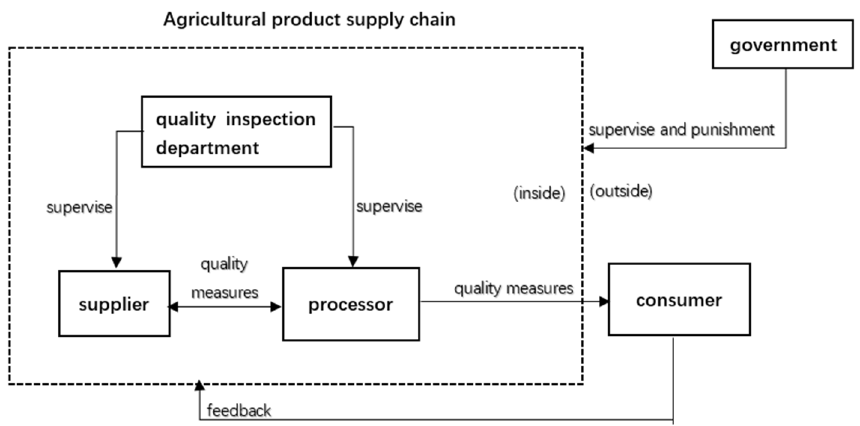
Figure 1. Game relationship among suppliers, processors, and quality inspection departments of agricultural products supply chain. agricultural products supply